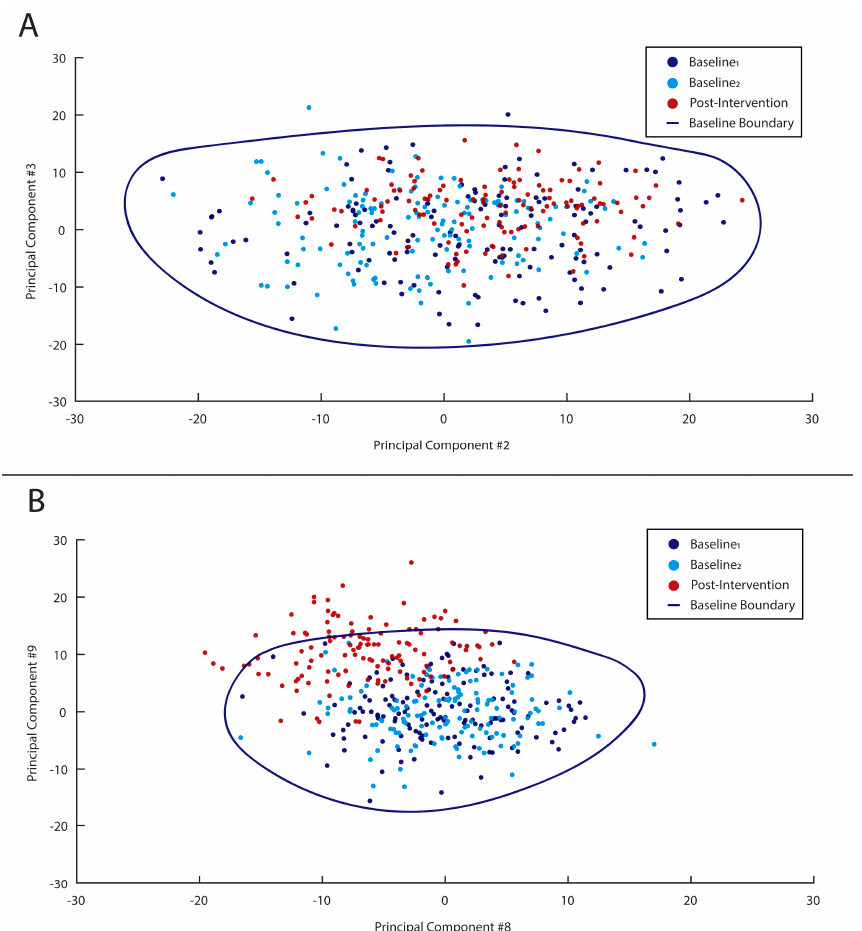
Figure 2. Simplified visualizations of boundary definitions (blue line) defined by baseline data (dark blue and light blue circles) and tested on post-intervention data (red circles). In example ( A ), no post-intervention gait cycles are defined as outliers, while in example ( B ) approximately 30% are viewed as outliers.